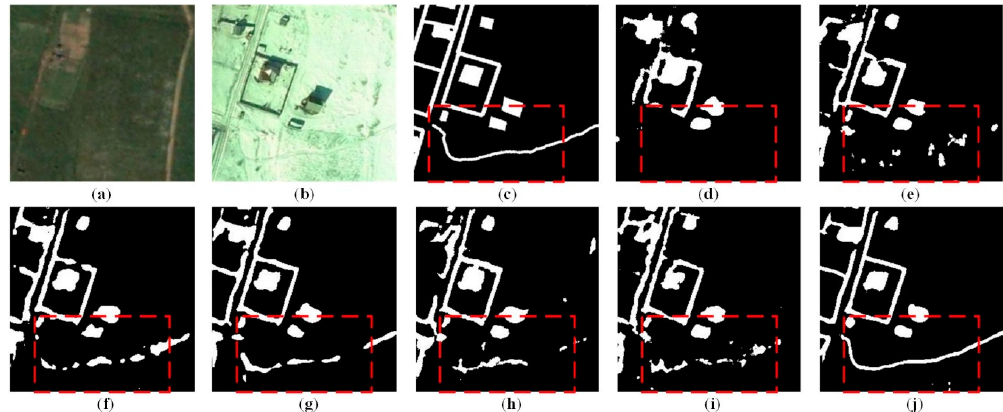
white while the unchanged part are in black.